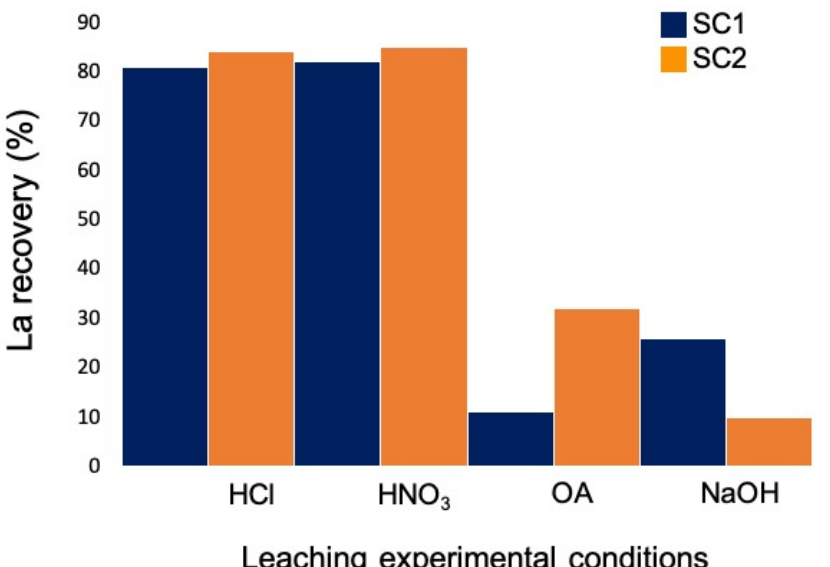
Figure 3. Experimental conditions and lanthanum recovery of the different tests carried out from SC1 (blue) and SC2 (orange) powders.